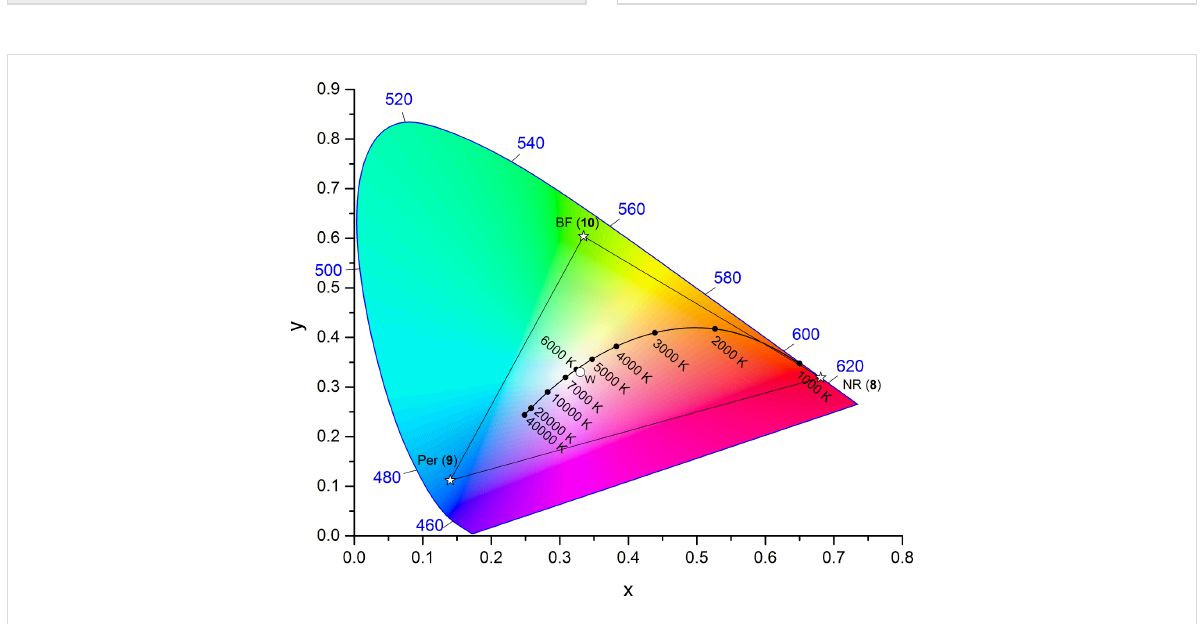
Figure 1: Absorption (a) and emission (b) spectra of perylene 9 , benzofurazane 10 , and Nile red precursors 8 (recorded in ethanol at T = 298 K; ([9] = 4.1 × 10 − 6 M, [10] = 4.0 × 10 − 6 M, [8] = 4.1 × 10 − 6 M; λ exc ( 9 ) = 409 nm, λ exc ( 10 ) = 450 nm, λ exc ( 8 ) = 540 nm).